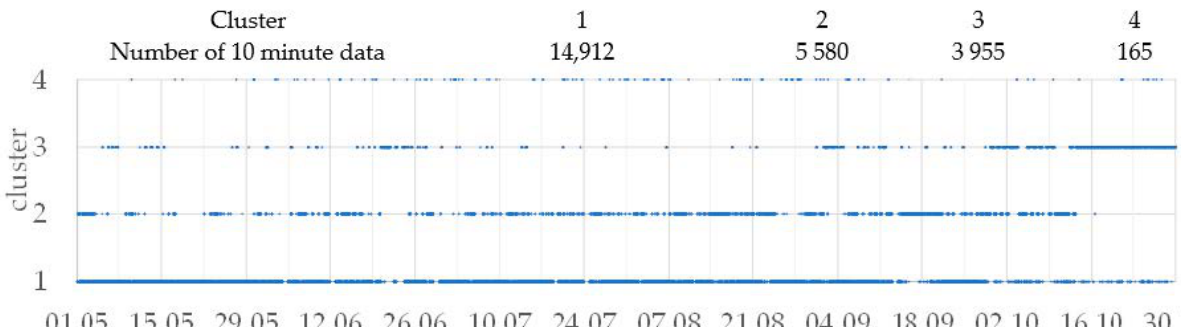
Figure 5. Clustering results in the point of cluster size and time domain.